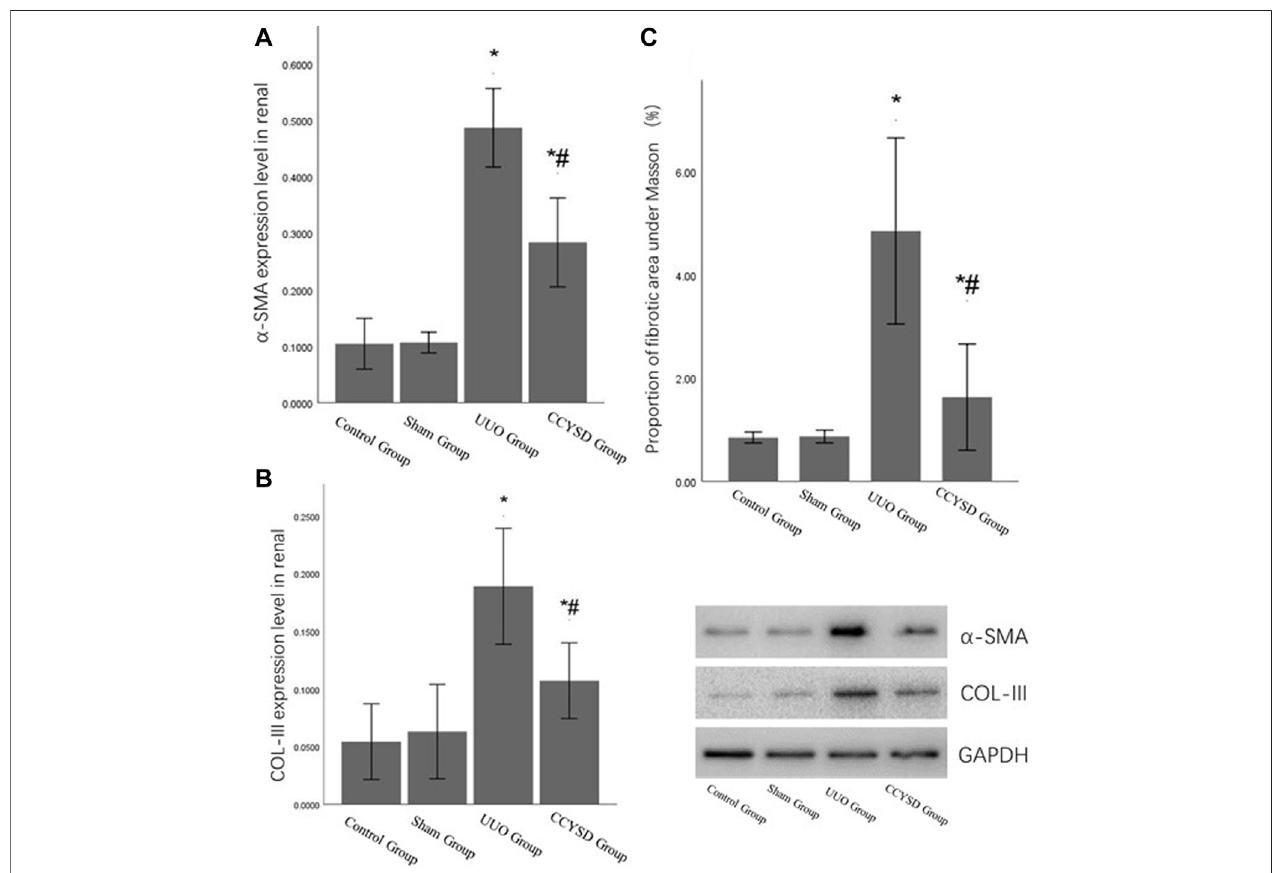
FIGURE 7 | TIF levels in each group. (A) : α -SMA relative expression level in renal tissue; (B) : col-III relative expression level in renal tissue; (C) : the area of TIF with Masson staining; *compared with the sham group, p < 0.05; and # compared with the UUO group, p < 0.05.